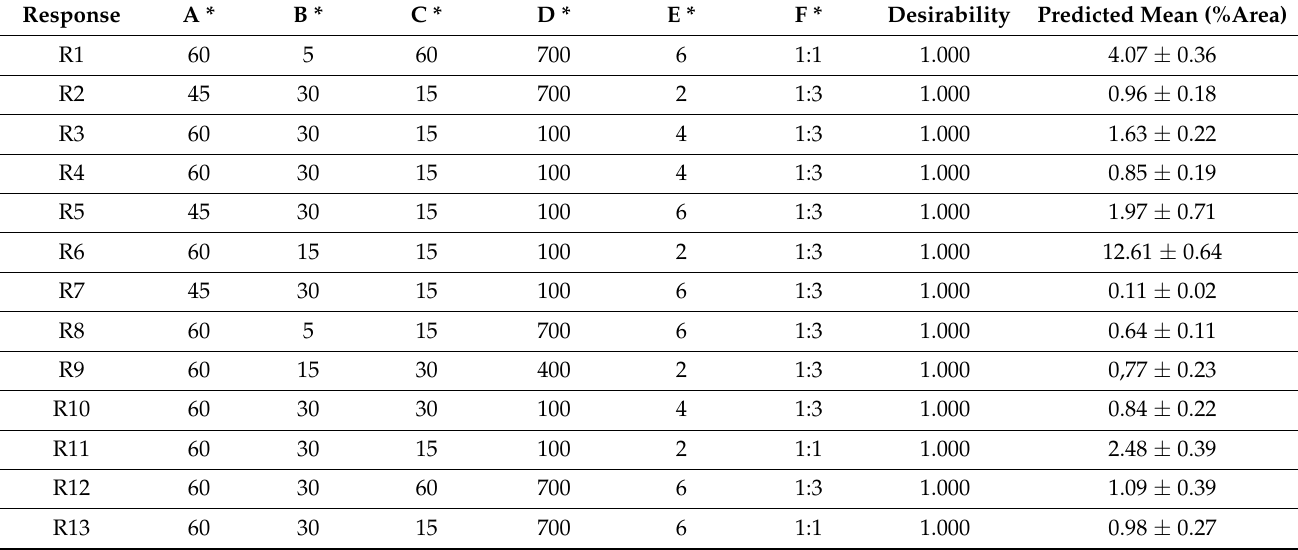
Table 6. Optimum conditions, desirabilities and predicted mean for each dominant volatile compound.